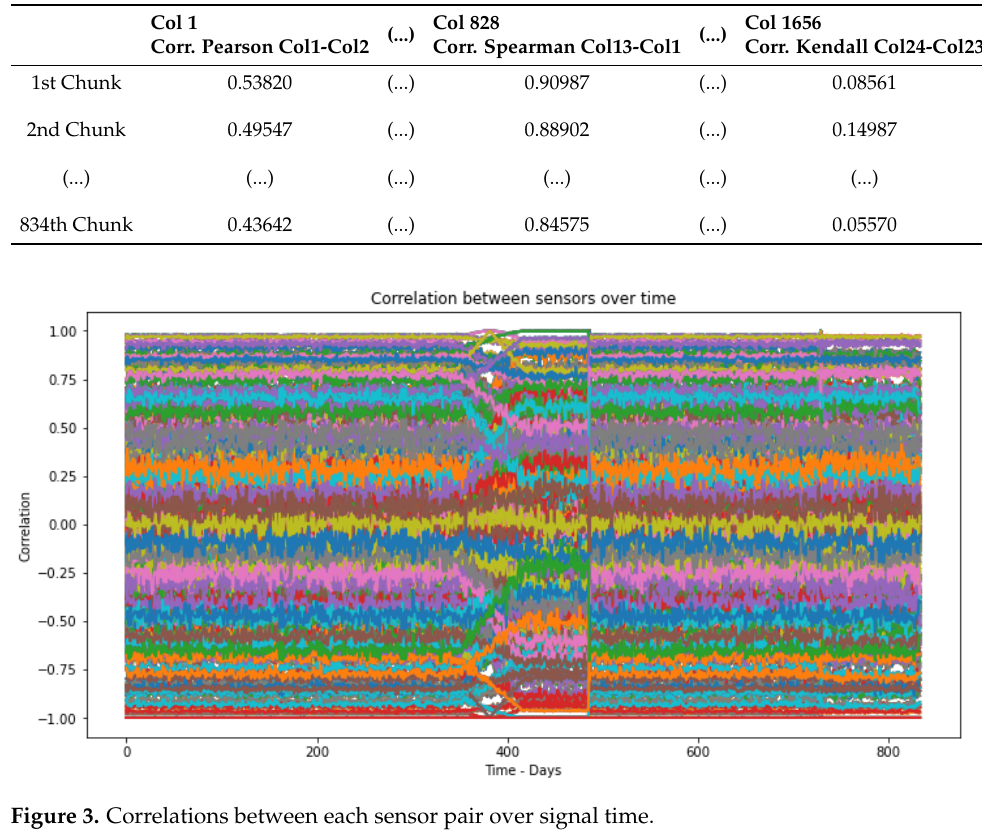
Table 2. Correlations between each pair of sensors in each of the time windows.